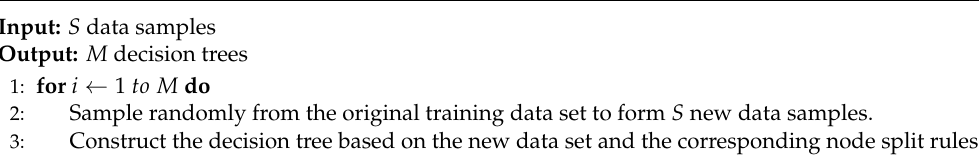
Algorithm 3 Main training steps of random